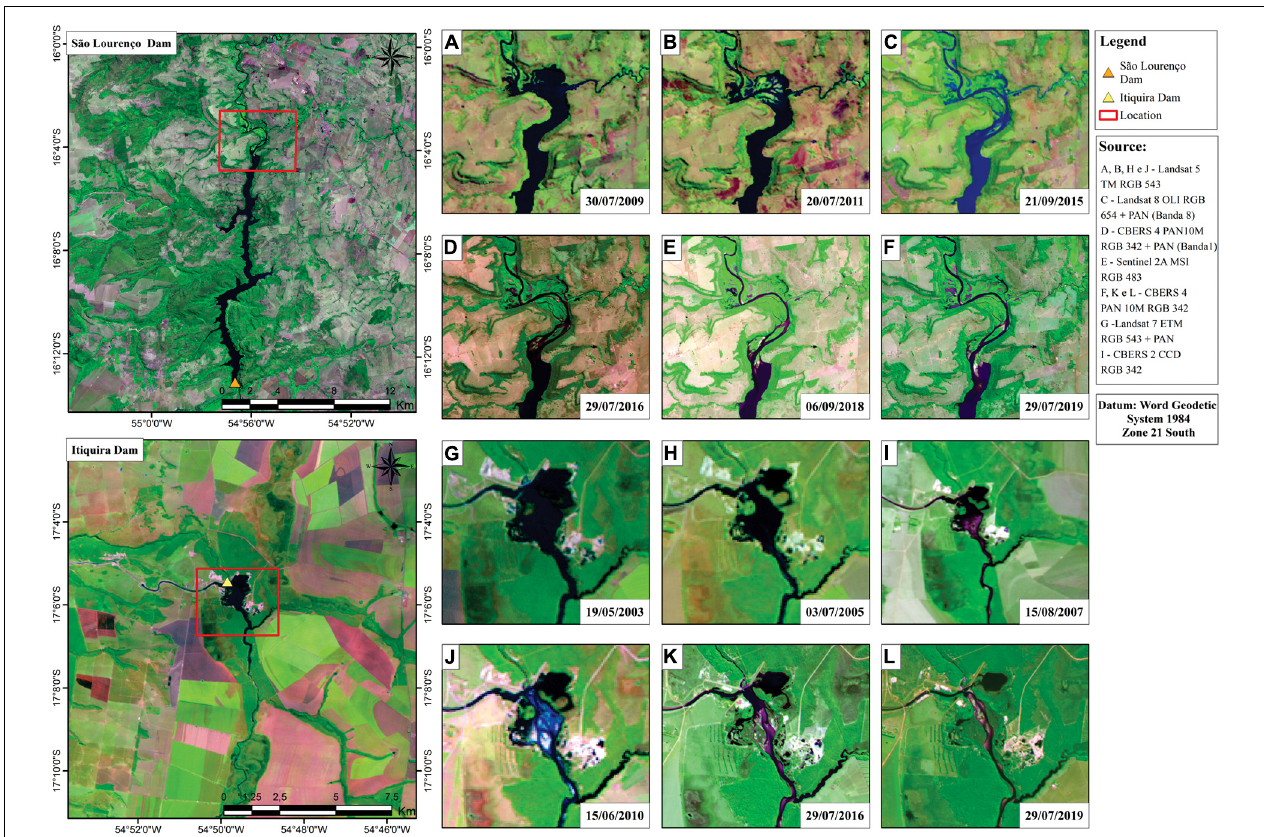
FIGURE 9 | Satellite images showing progressive sedimentation and infilling of reservoirs created by the (A–F) Itiquira dam (completed in 2002) and (G–L) São Lourenço dam (completed in